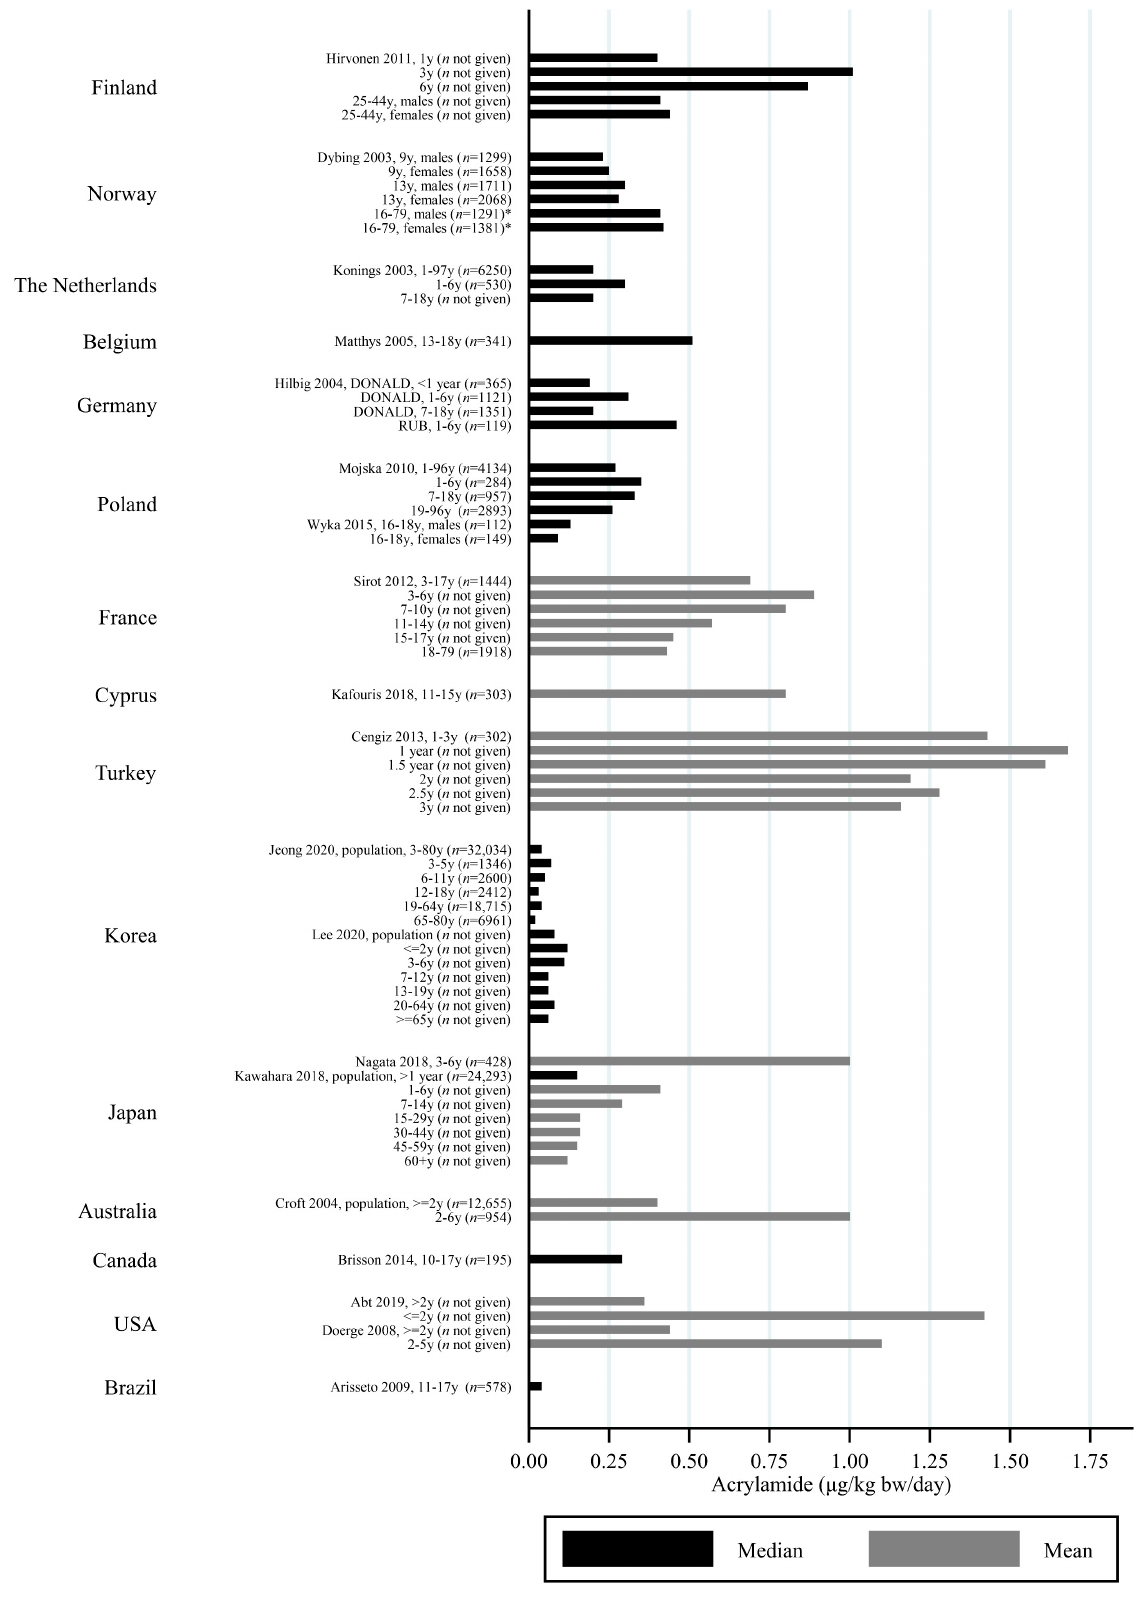
Figure 8. Median/mean estimated daily acrylamide intake per kg body weight ( µ g/kg bw/day) based on dietary recall in studies including children, by country. * Dybing et al., 2003 [43] estimated AA intake in adults using